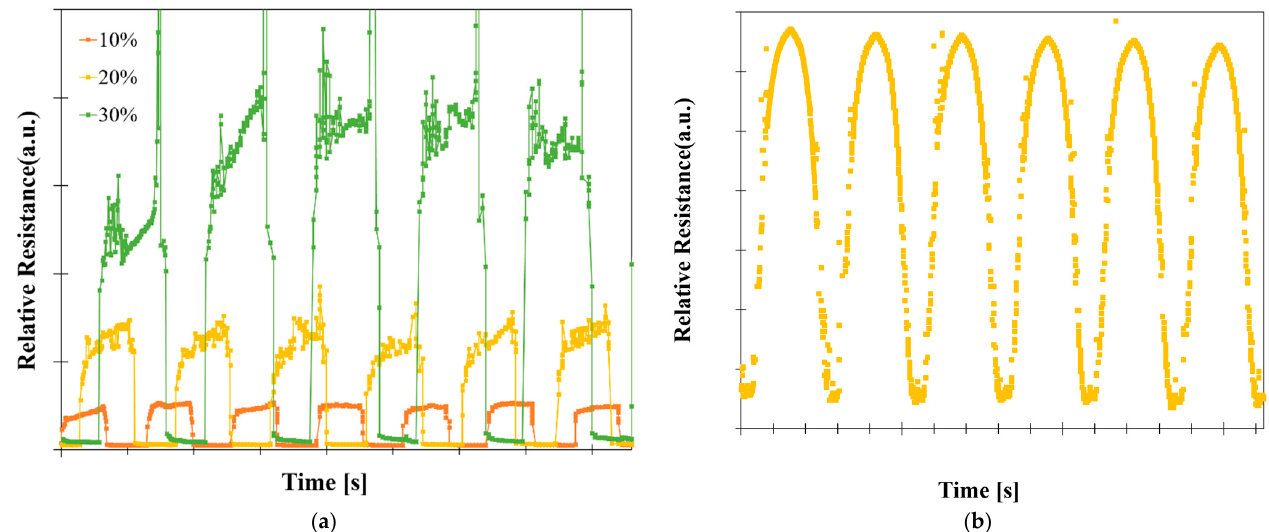
Figure 15. Transient measurement of Sample C: ( a ) relative resistance change as a function of time at 10%, 20%, and 30% strain; ( b ) transient curve at the tensile speed of 6 mm/min and a waiting time of 0.1 s.